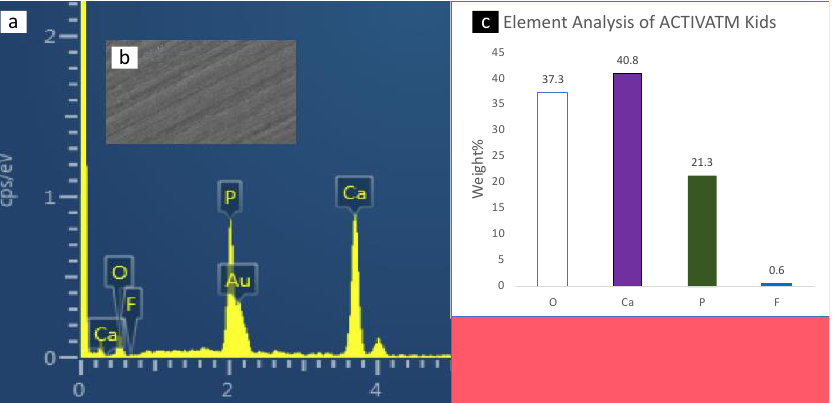
Figure 7. The SEM-EDX evaluation of the enamel samples under ACTIVA KIDS: ( a ) the SEM-EDX spectrum shows the dominant elements; ( b ) SEM image of the area for which the EDX spectrum was acquired; ( c ) concentrations of elements in weight (weight percent) of the oxygen, calcium, phosphate and fluoride elements found in enamel surface under the sealants.